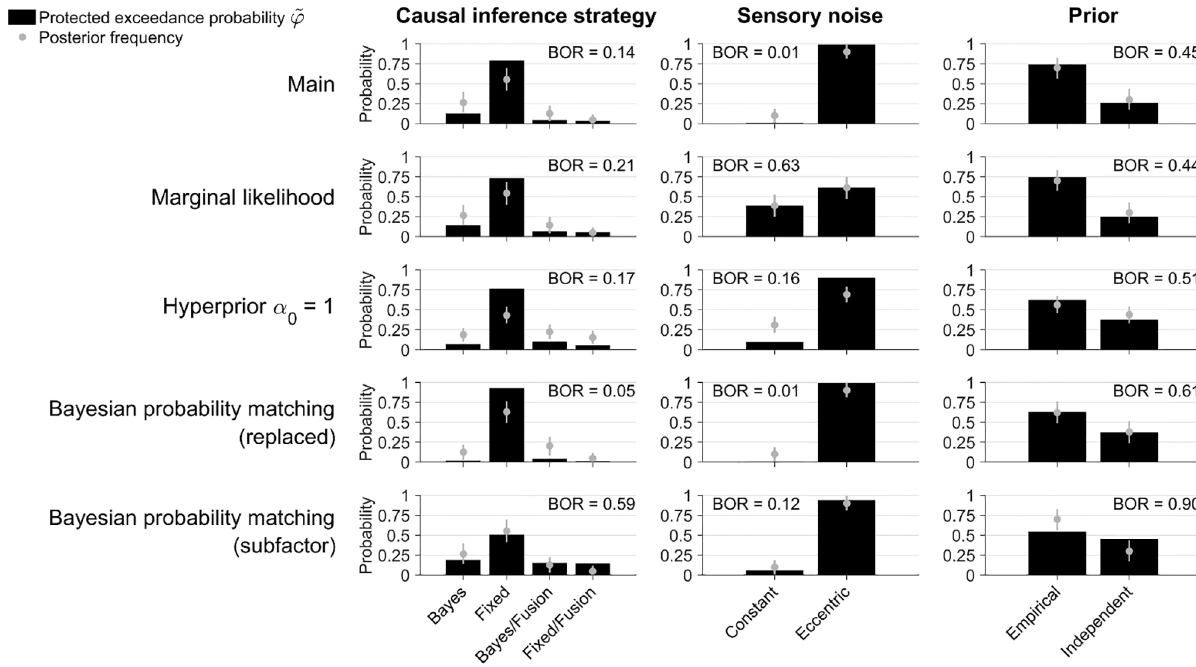
Fig 7. Sensitivity analysis of factorial model comparison. Protected exceedance probability ~ φ of distinct model components for each model factor in the joint fits. Each panel also shows the estimated posterior frequency (mean ± SD) of distinct model components, and the Bayesian omnibus risk (BOR). Each row represents a variant of the factorial comparison. 1st row: Main analysis (as per Fig 6A). 2nd row: Uses marginal likelihood as model comparison metric. 3rd row: Uses hyperprior α 0 = 1 for the frequencies over models in the population (instead of a flat prior over model factors). 4th row: Uses ‘probability matching’ strategy for the Bayesian causal inference model (replacing model averaging). 5th row: Includes probability matching as a sub-factor of the Bayesian causal inference family (in addition to model averaging).